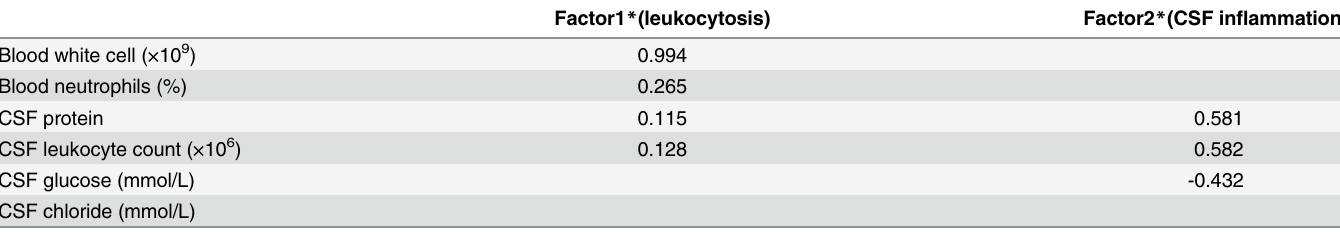
Table 5. Exploratory factor analysis result by using blood and cerebrospinal fluid (CSF) biochemistry test results from 541 cases.